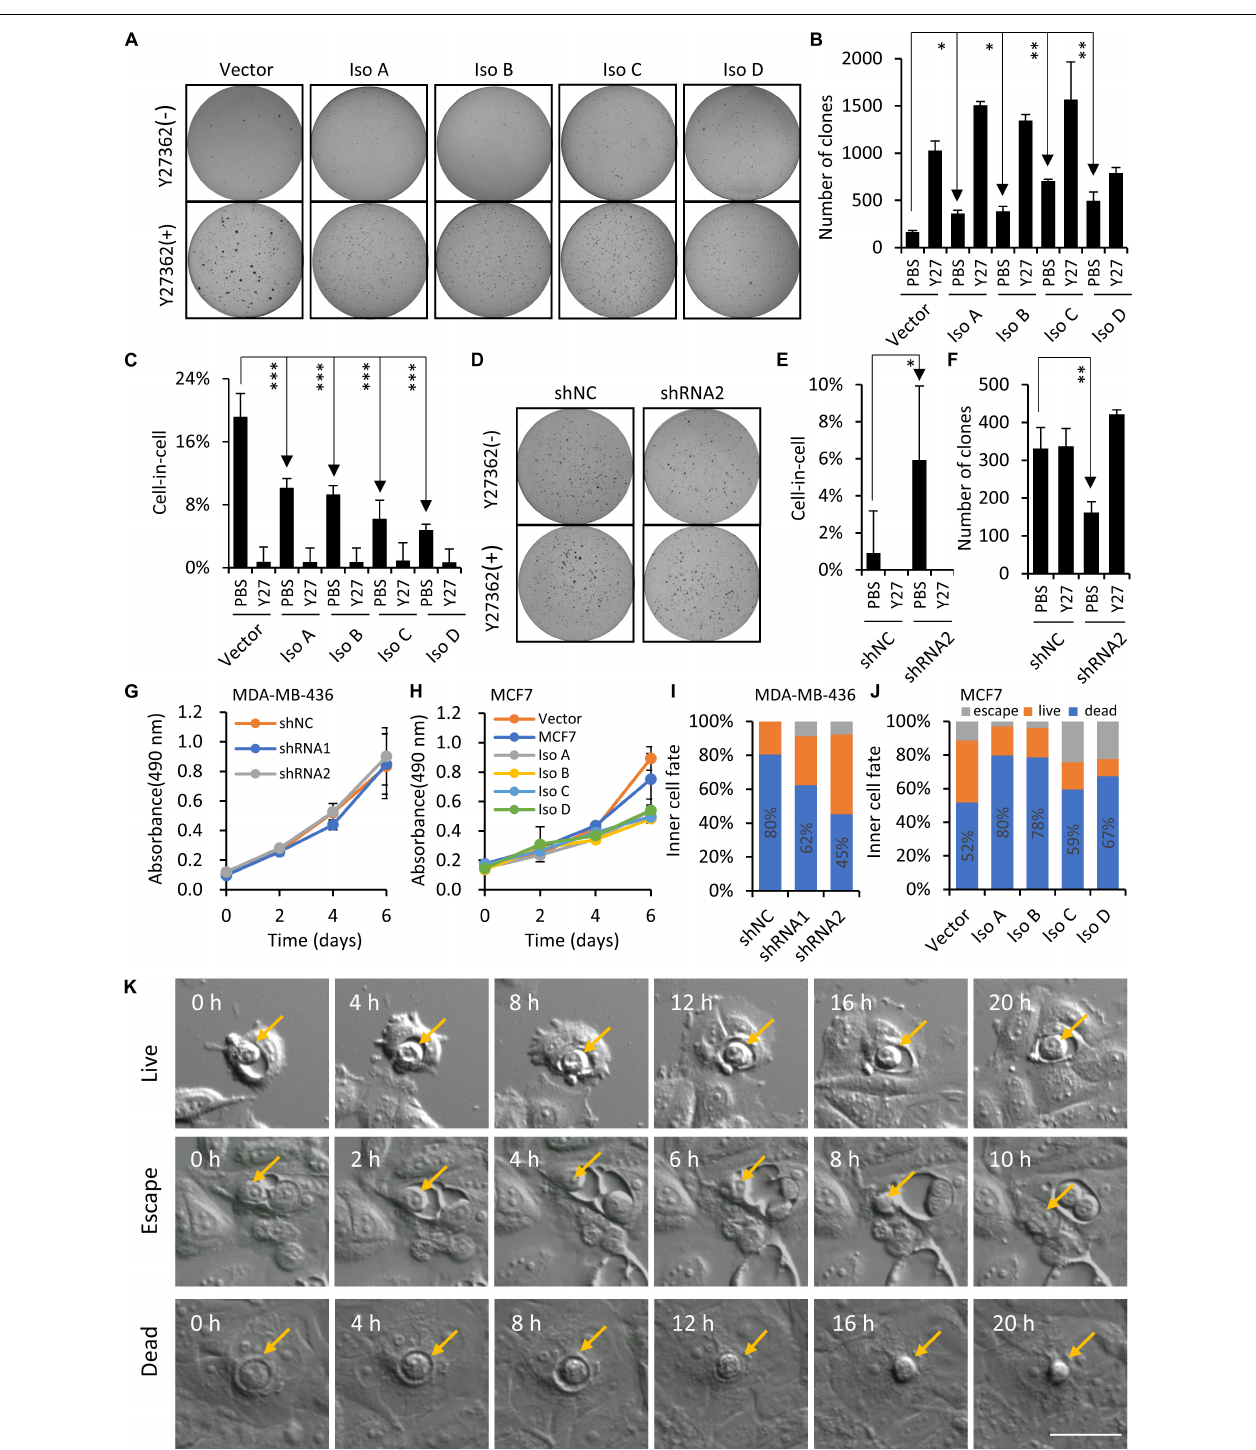
FIGURE 5 | PCDH7 enhances anchorage-independent cell growth. (A–C) PCDH7 overexpression promotes anchorage-independent colony formation of MCF7 cells in soft agar, which is associated with inhibited CIC formation. Y27: Y27632. Data are mean ± SD of triplicate experiments. ∗ P < 0.05; ∗∗ P < 0.01; ∗∗∗ P < 0.001. (D–F) PCDH7 depletion suppresses colony formation of MDA-MB-436 cells in soft agar in a CIC-dependent manner. Y27: Y27632. Data are mean ± SD of triplicate experiments. ∗ P < 0.05; ∗∗ P < 0.01. (G,H) Growth curves for PCDH7 -depleted (G) or -overexpressing (H) cells cultured under adherent condition. Data are mean ± SD of triplicate experiments. (I,J) Inner cell fate analysis in cells with PCDH7 depletion (I) or overexpression (J) . n > 40 each. (K) Representative image sequences showing three major fates of internalized cells. Scale bar: 50 µ m.